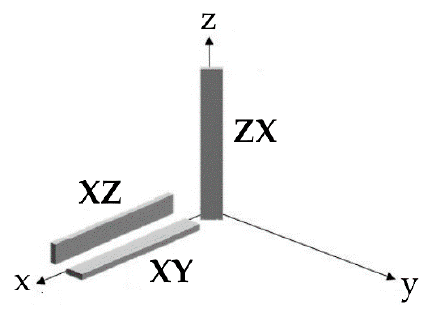
Figure 1. FDM samples built according XY, XZ, and ZX directions.